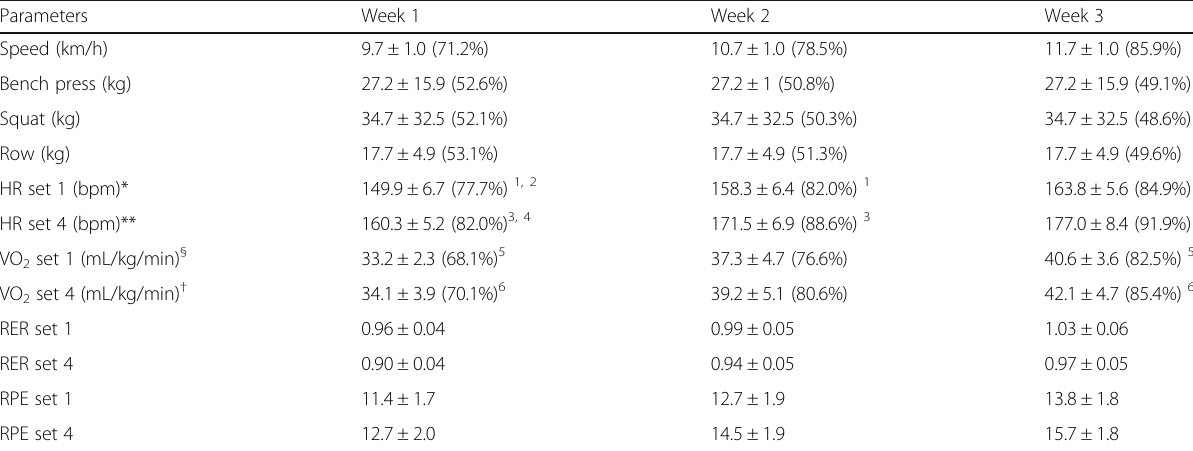
Table 2 Training parameters of the subjects Parameters